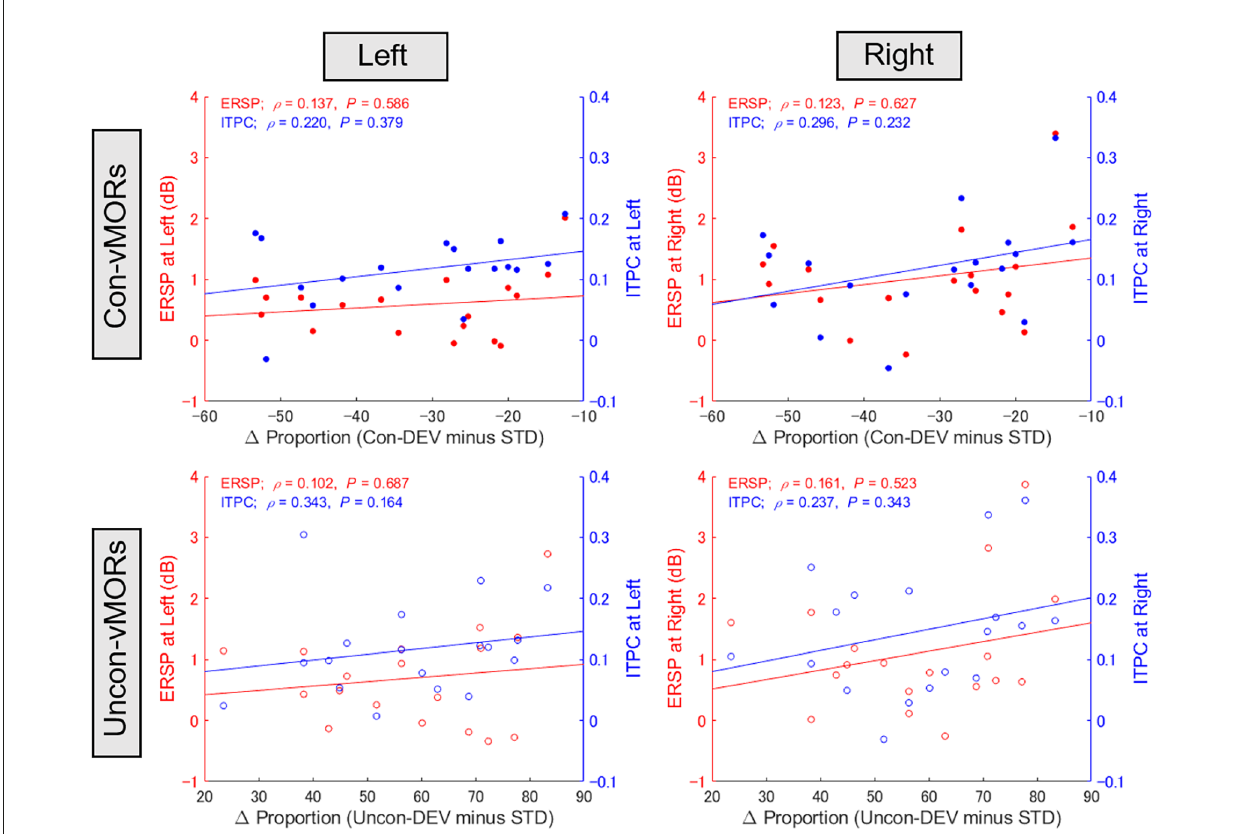
FIGURE6 Relationship between proportion of perceptual alternation and alpha-band ERSP/ITPC. The correlations between the differential proportion of perceptual alternation and ERSP/ITPC of vMORs in the alpha band are shown for each condition. ERSP and ITPC in the left area (PO3, PO7) and right area (PO4, PO8) were calculated for each participant in the time-frequency window of 100–500 ms and 9–13 Hz,